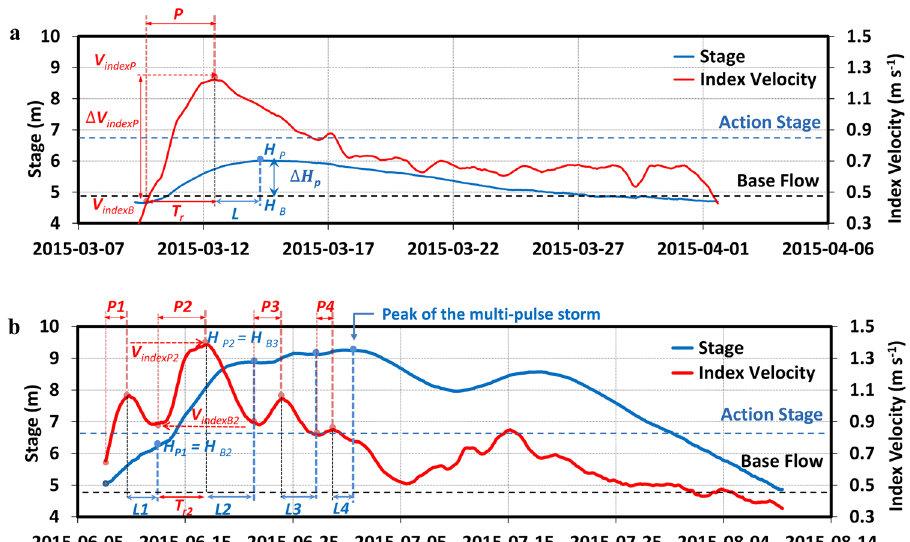
Fig. 3 Identi fi cation of the hysteresis-related patterns for developing fl ood wave crest amplitude and arrival time forecasting protocol (Supplementary Data 4). a Single-pulse storm event and b multiple-pulse storm